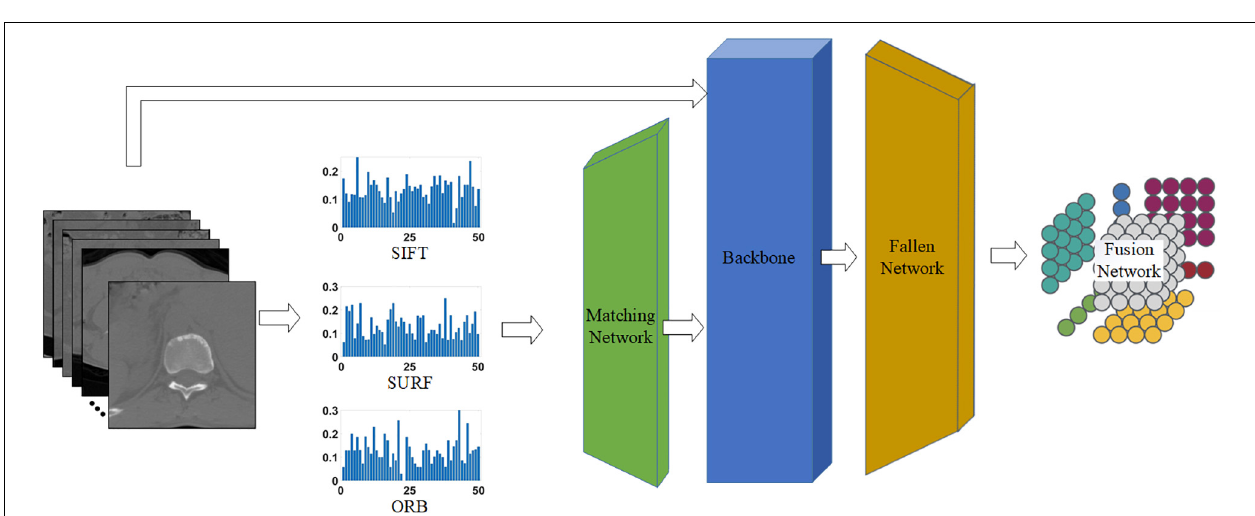
FIGURE 4 | Proposed network for classifying tuberculosis images. The middle three histograms are the SIFT, SURF, ORB vectors with length of 50 extracted from raw CT images, and the green, blue, and orange block represent the matching network, backbone, and fallen network, respectively. The matching network and fallen network are illustrated in Figures 5A,B , respectively, and the last block is the fusion network, which is illustrated in Figure 5C